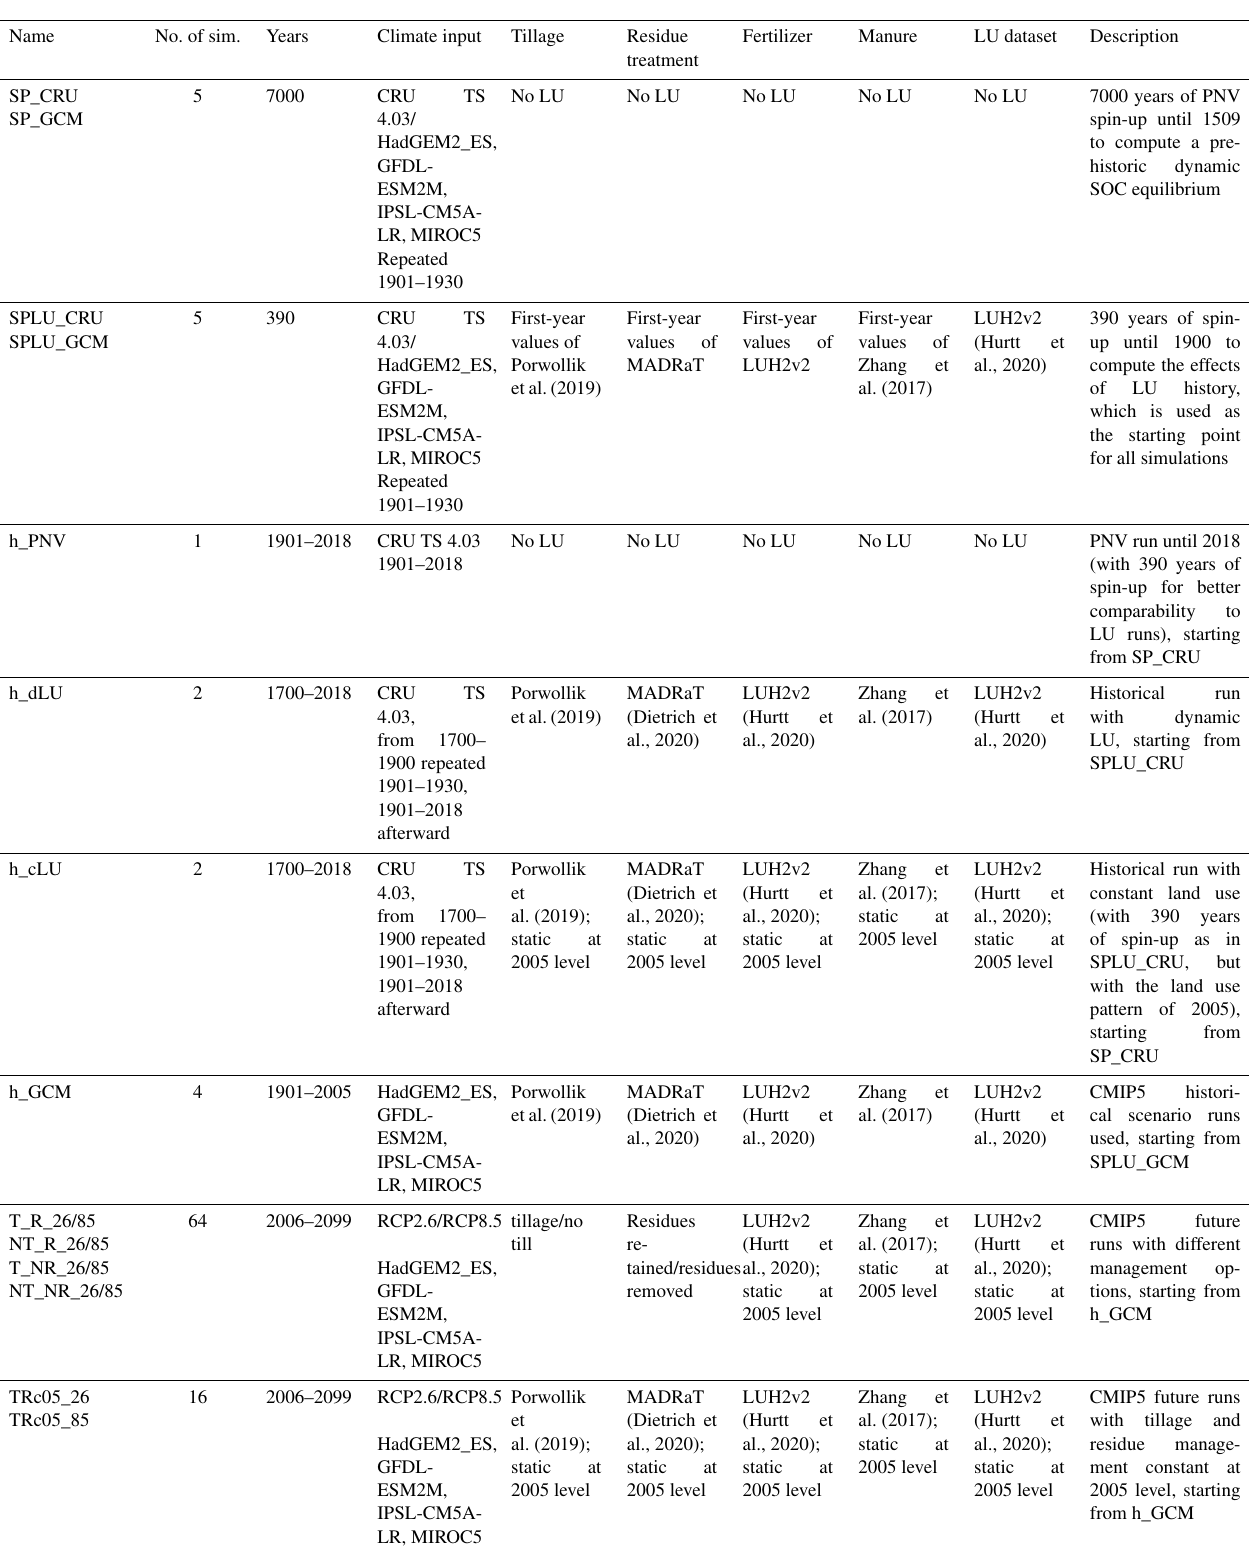
Table 1. Overview of the different simulations conducted for this study. For more details and the purposes of the simulation, see the text. No LU: no land use, PNV: potential natural